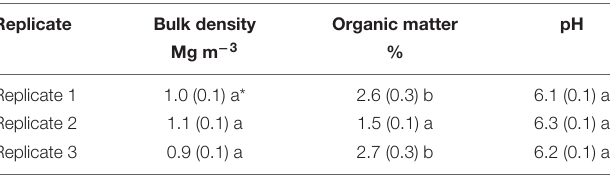
TABLE 1 | Fine-fraction soil bulk density, organic matter concentration, and pH in each replicate of the Cedar Fire study site averaged ( ± SE) across hydromulch-treated and control